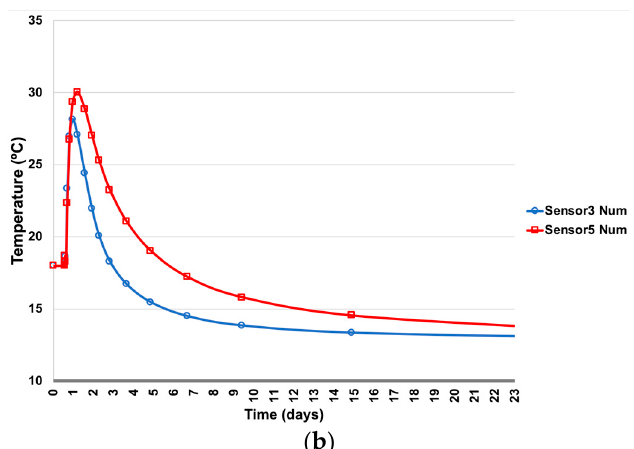
Figure 16. ( a ) Thermo-chemical-mechanical FEM model of the footing; ( b ) Numerical prediction of the evolution of temperature with age for sensors 3 and 5.